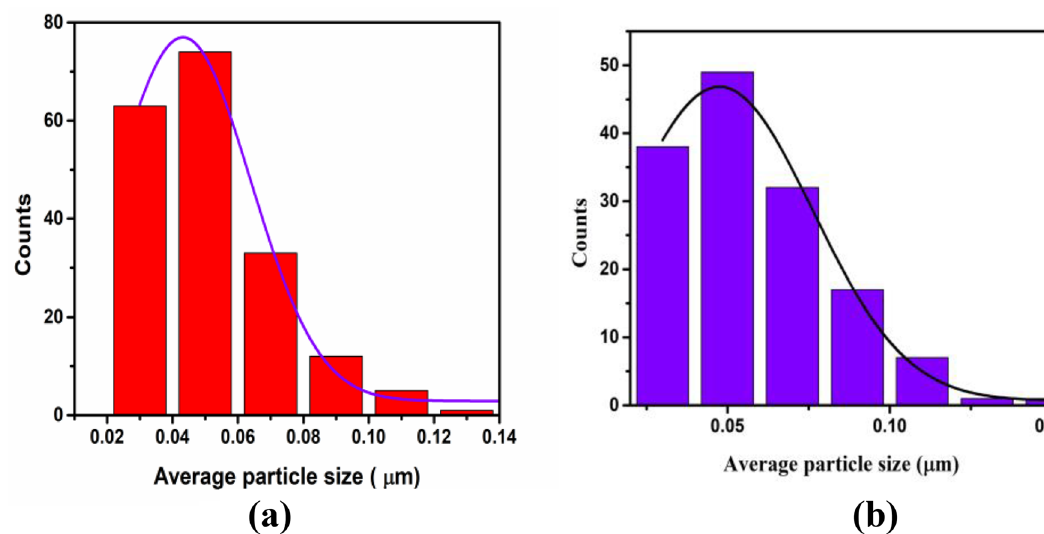
Fig. 5 Histograms showing grain size distribution. a CaO-M, and b